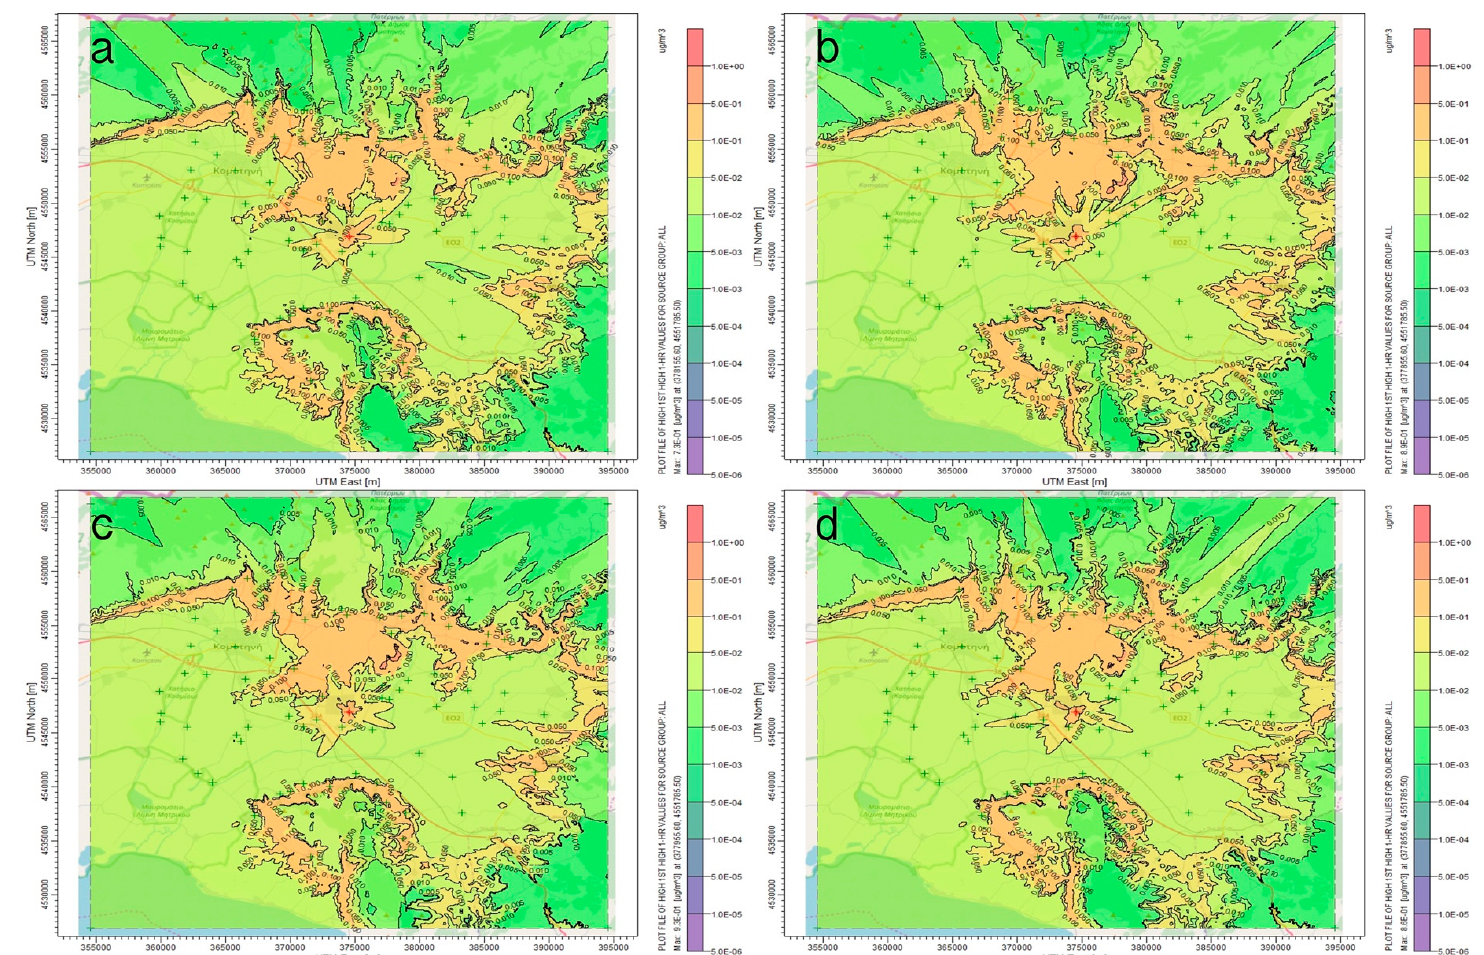
Figure 6. The highest hourly values of TSP of Pb ( µ g m − 3 ) ( a ) the legal limit operating conditions for 2015 ( b ) the legal limit operating conditions for 2016, ( c ) the legal limit operating conditions for 2017, and ( d ) the legal limit operating conditions for 2018.